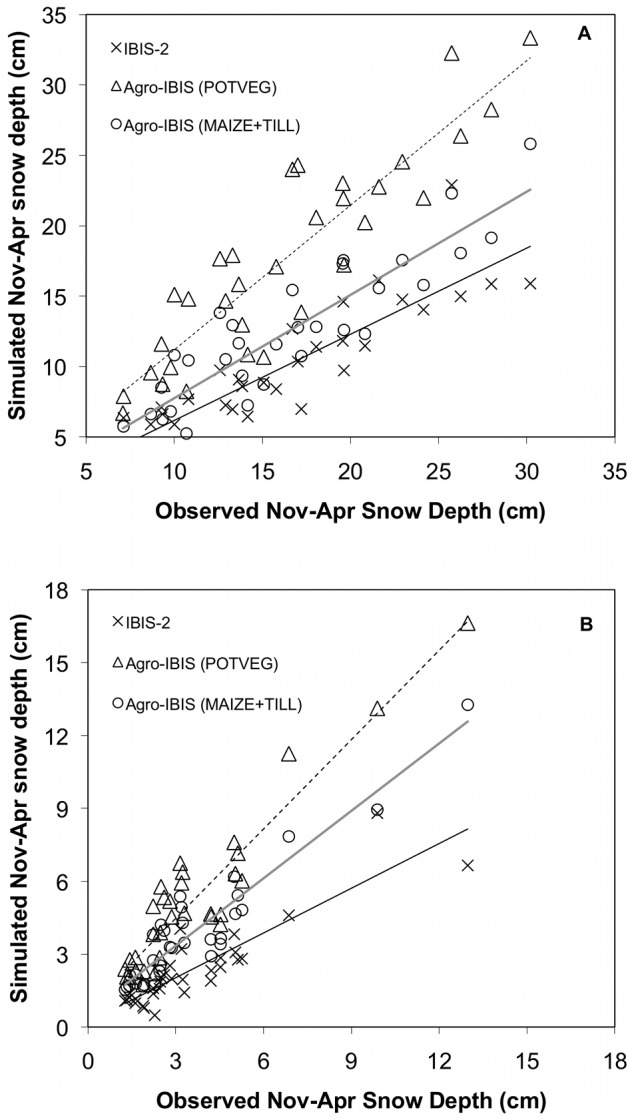
Observed versus simulated interannual variability of mean Nov-Apr snow depth.Comparison of observed versus Agro-IBIS model simulated mean Nov-Apr snow depth for each year from 1963–1995 in (a) northern (43.5° to 47.5°N lat; −94.0 and −83.0°W lon) and (b) southern (39.5° to 43.49°N lat; −94.0 and −83.0°W lon) areas where observation stations were located. Previous IBIS-2 model results (Lenters et al., 2000) are plotted for comparison. Linear regression fits between observations and model results are denoted by the following lines: thin black (IBIS-2); gray solid (MAIZE+TILL); black dashed (POTVEG).